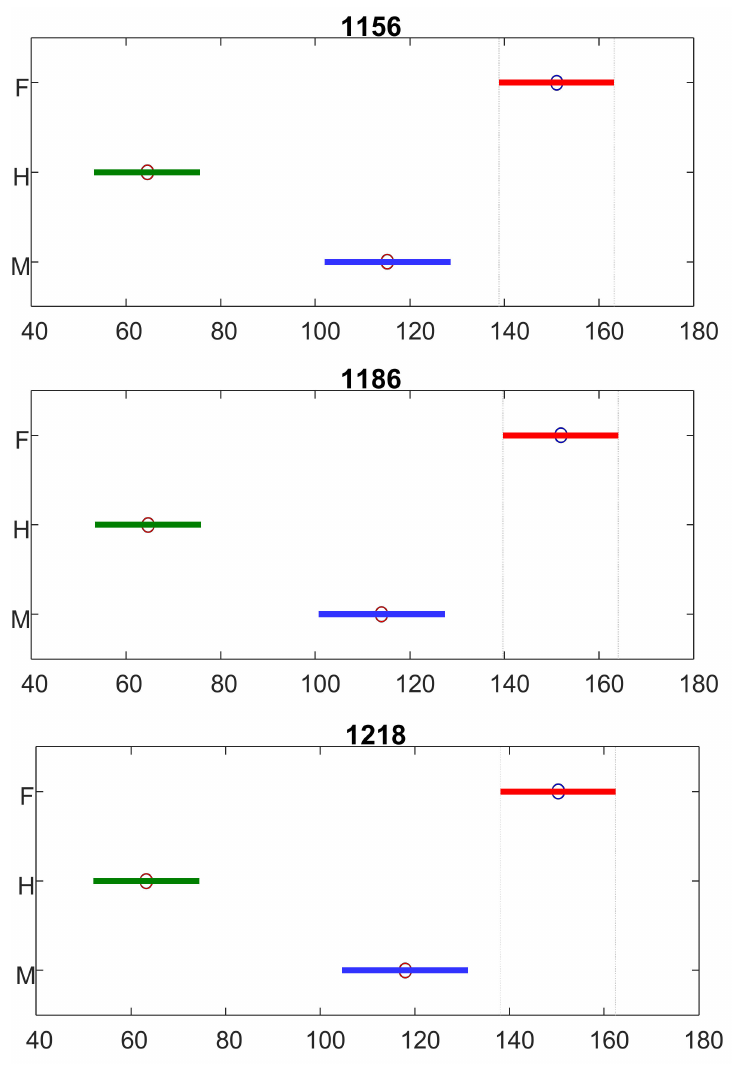
Figure 2. ANOVA of the intensity of 1156, 1186, and 1218 cm − 1 bands demonstrate statistically significant differences in these vibrations that can be used as marker bands for differentiation between female (F), hermaphrodites (H), and male (M) cannabis plants. The ANOVA also reported a 95% confidence interval for the true value of median for each compared group. X axes represent ranks of 1156, 1186, and 1218 cm − 1 band intensities (Dou, et. al.,